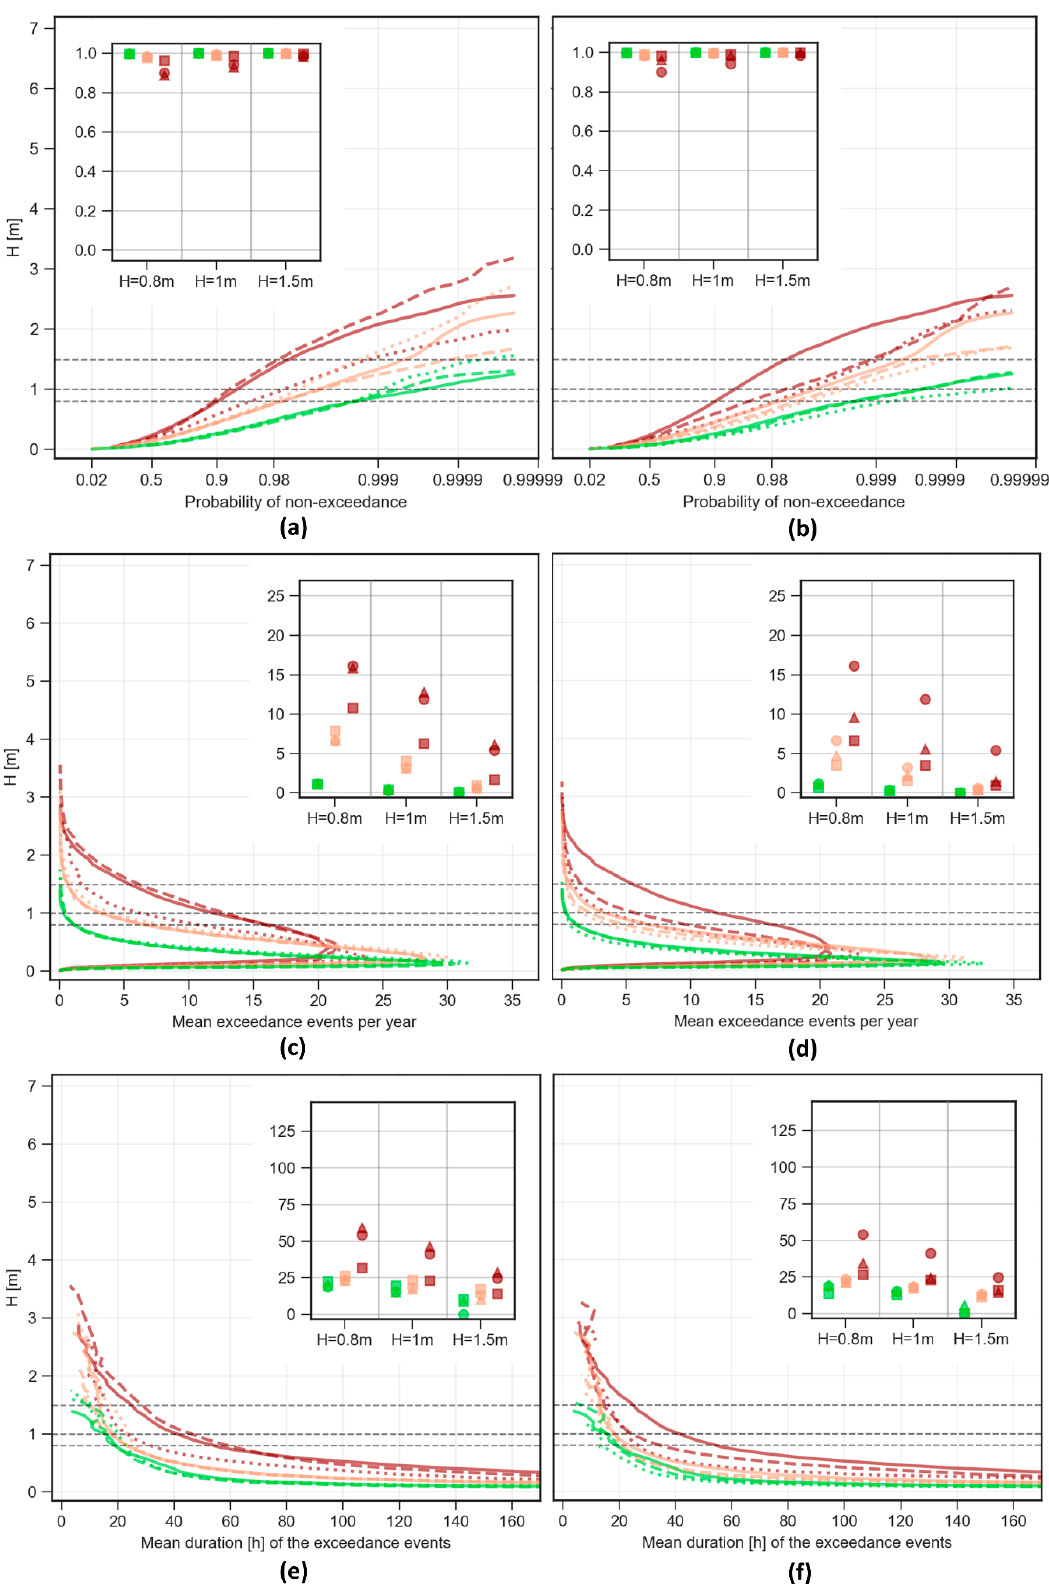
Figure A6. Comparative of operability indicators for Type 2 AOIs, including a detail of a threshold overcoming analysis for the complete sets of: ( a ) PROB , short-term; ( b ) PROB , long-term; ( c ) N , short-term; ( d ) N , long-term; ( e ) T , short-term; ( f ) T , long-term.